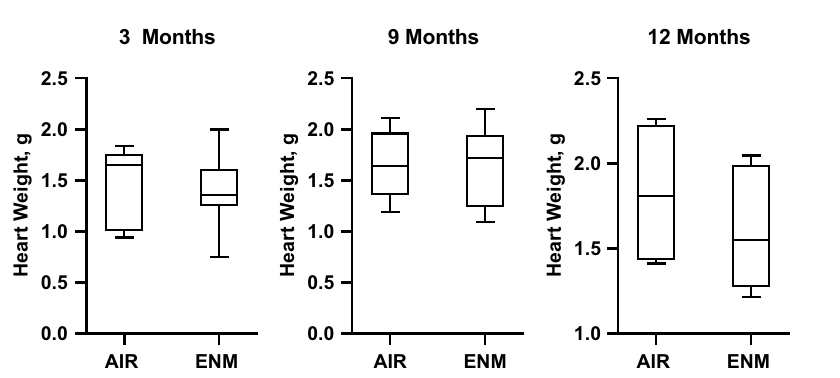
Figure 3. Heart Weight. Heart weight of offspring in Sham-Control (gray bars) and ENM (black bars) offspring at 3, 9, and 12 months of age. Values are shown as mean ± SEM. Statistics were analyzed with a Students T-test ( p <